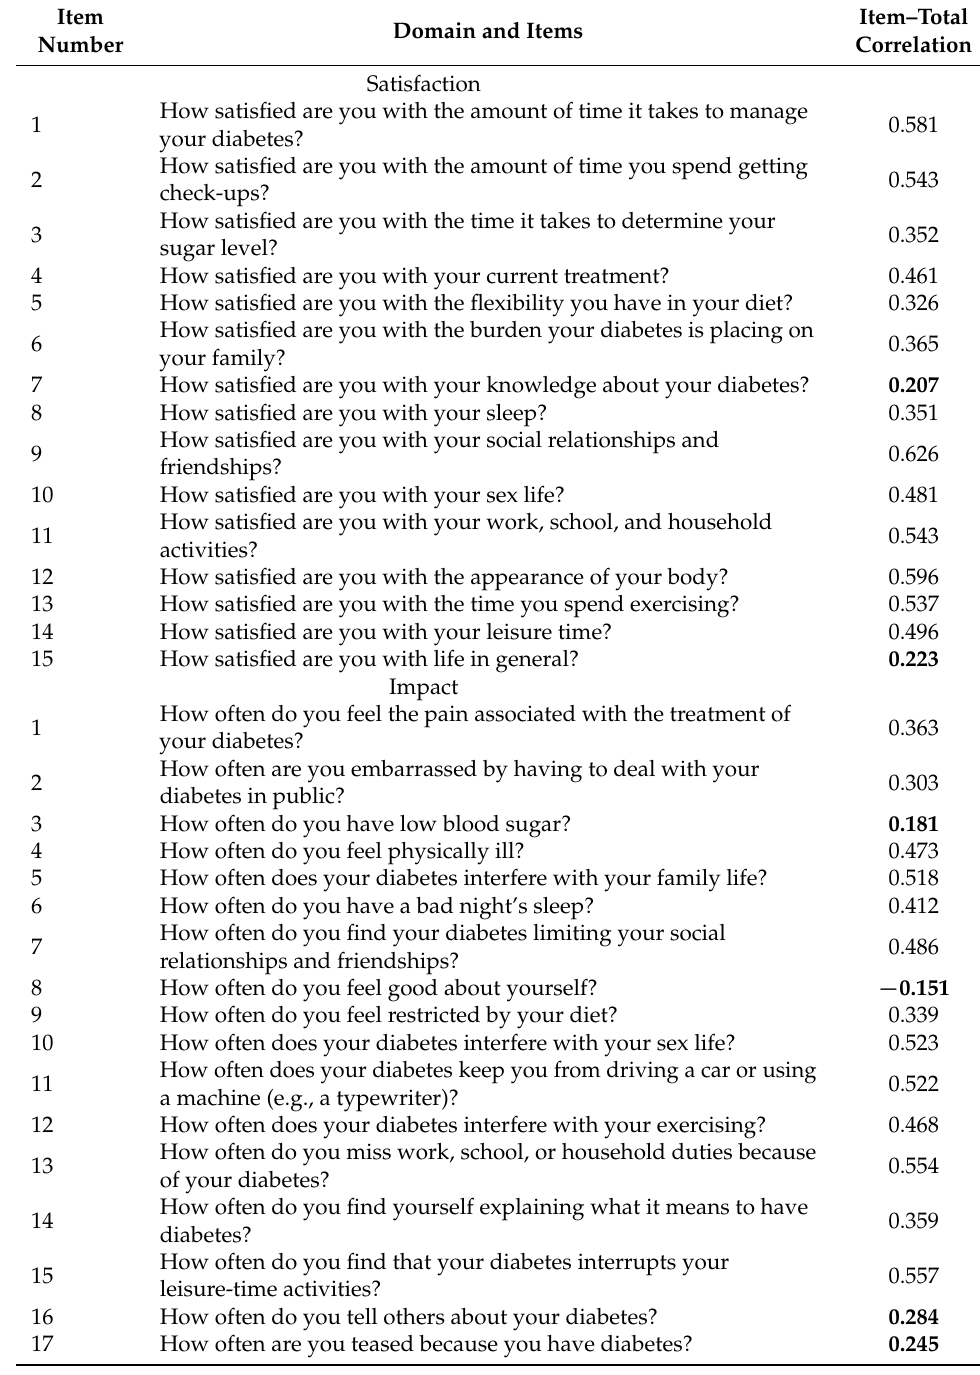
Table 2. Item–total statistics of the DQOL-AO version among adults living with type 2 diabetes attending Nekemte Specialized Hospital, 2020 ( n =